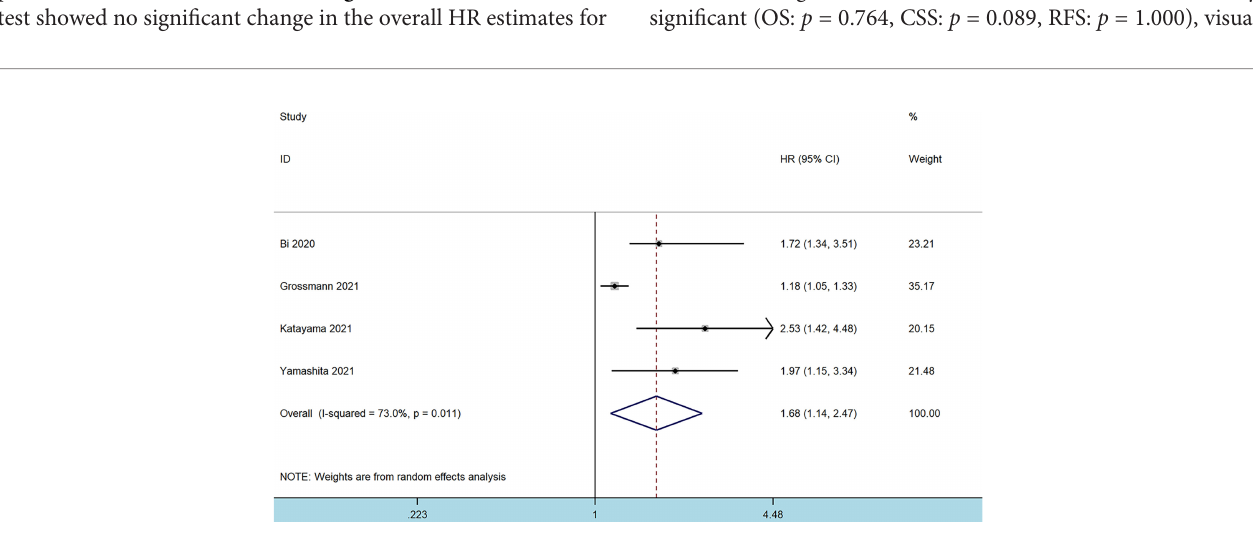
FIGURE 3 | Forest plot of the association between systemic immune-in fl ammation index and cancer-speci fi c survival in patients with bladder